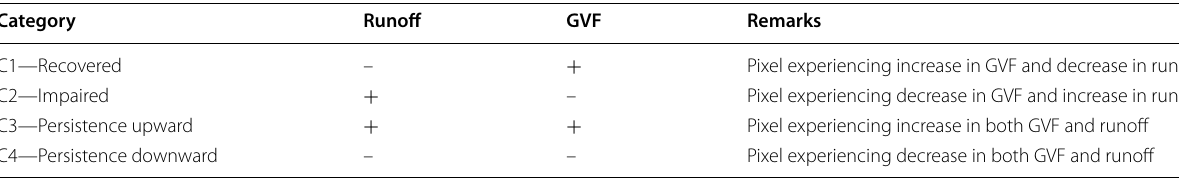
Table 2 Possible change direction based on types of changes of runoff and GVF from the t-0 (target year) and t-1 (the previous year)